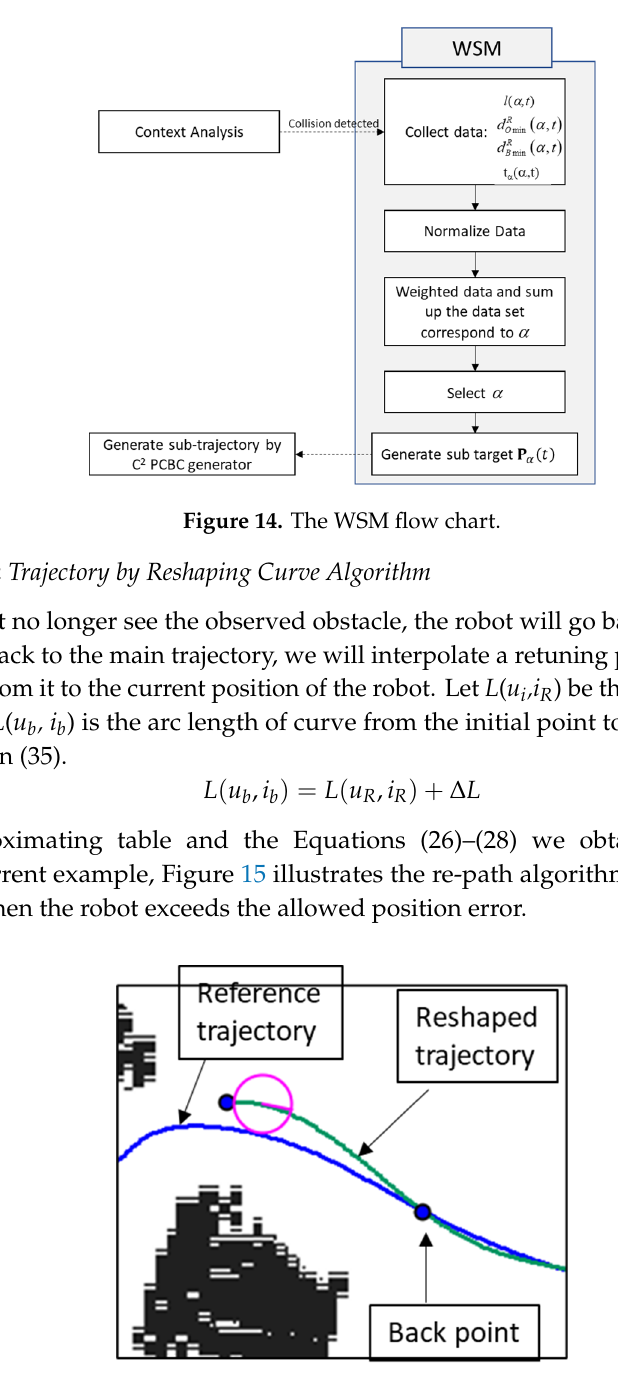
Figure 16. Mobile platform for experiments. Figure 17. The map of lab pre-built by the robot.